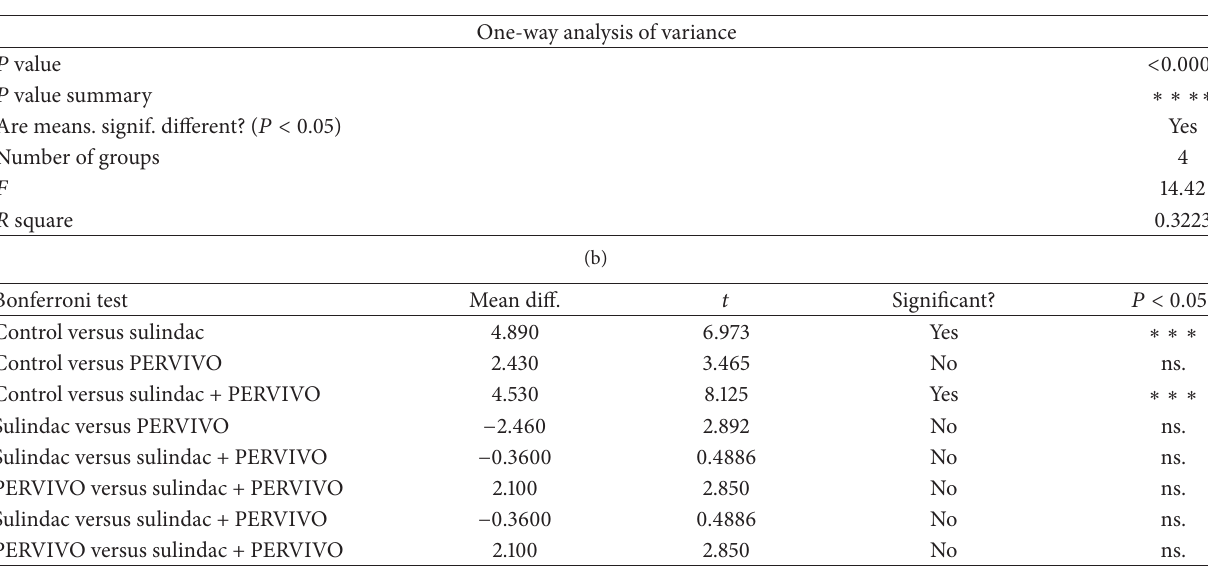
Table 4: Statistical analysis of the results presented in Figure 4.